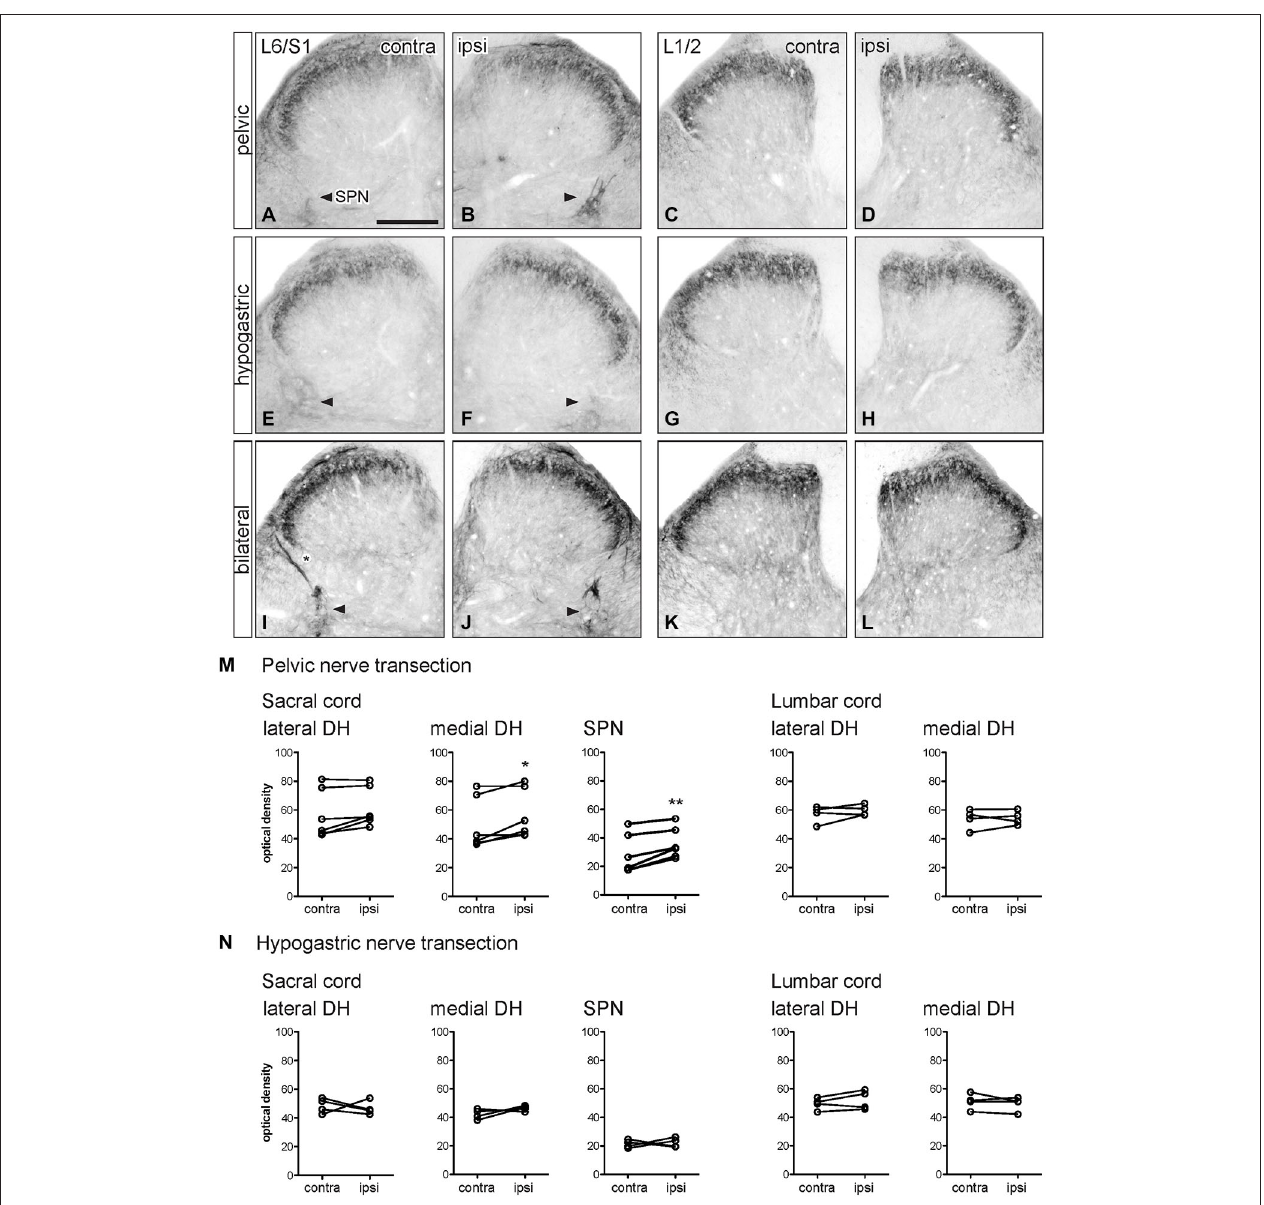
significant increase of GFR α 1-IR was observed in the medial dorsal horn and sacral parasympathetic nucleus (SPN) ipsilateral to injury. In lumbar spinal cord, no effect of injury on GFR α 1-IR was detected. (N) Hypogastric nerve transection had no effect on GFR α 1-IR in sacral or lumbar spinal cord. Data represents the mean ± SEM ( n = 6 rats for sacral data following unilateral pelvic nerve transection, n = 4 rats for lumbar data following unilateral pelvic and hypogastric nerve injury) and was analyzed using a paired t -test. The SPN in sacral cord is indicated with arrowheads (A,B,E,F,I,J) . Scale bar in A applies to all images and represents 200 µ